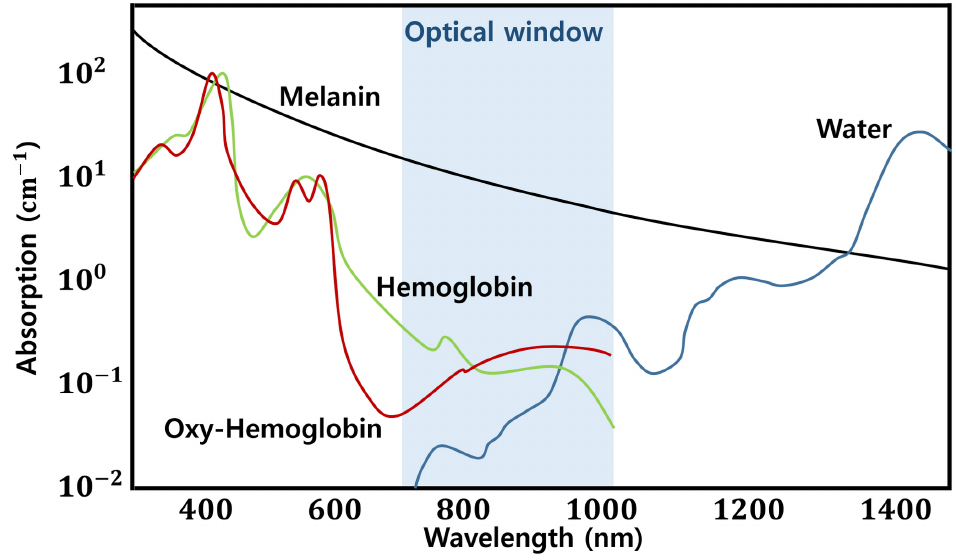
Figure 1. Graph for the absorption rate of water, melanin, and hemoglobin according to the wave- length of